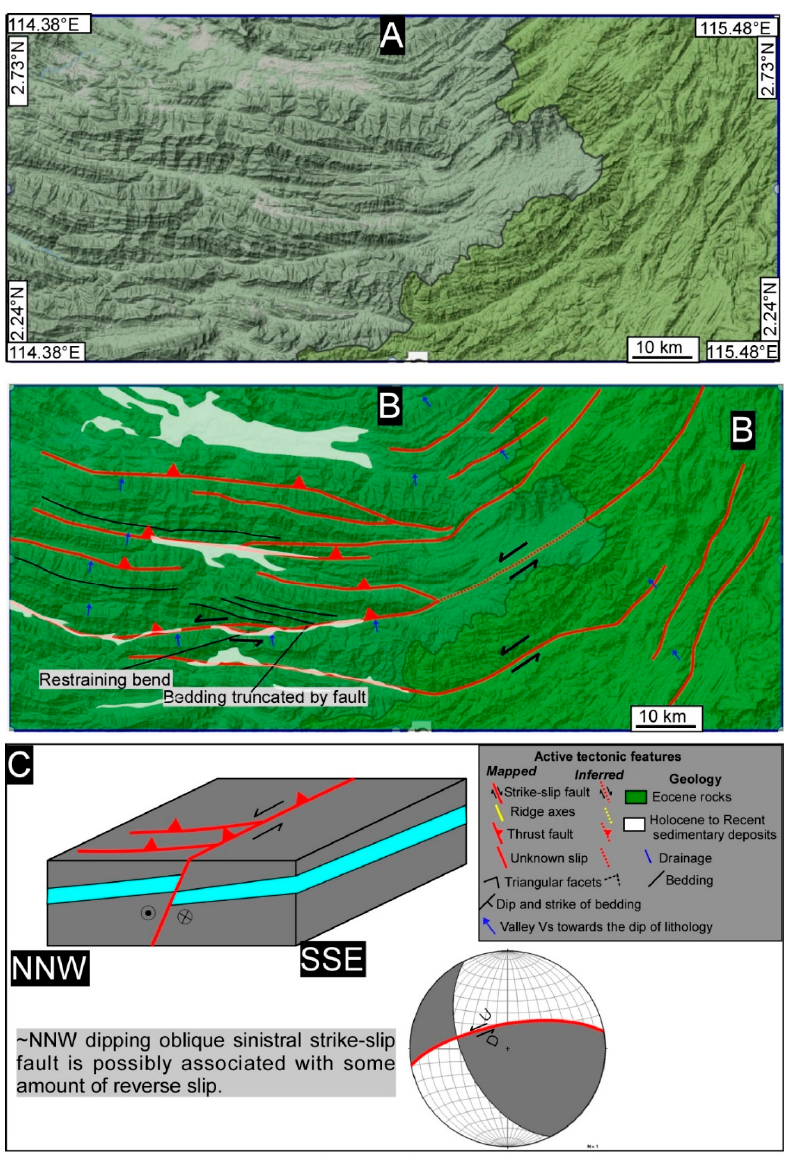
Figure 10. ( A ) Un-interpreted Google terrain image and ( B ) shows interpreted image. The evidence of truncated sedimentary beds by a major sinistral strike-slip fault where material is transported from ~north to ~south. The folding indicates a possible fault-bend fold geometry at depth, and a component of reverse slip along with strike-slip faulting. The reverse faults are fanning at the fault tip of the major fault, which indicates compression with strike-slip. ( C ) The expected fault plane solution and the associated cartoon show the possible nature of faulting where sinistral strike-slip faults have a component of reverse